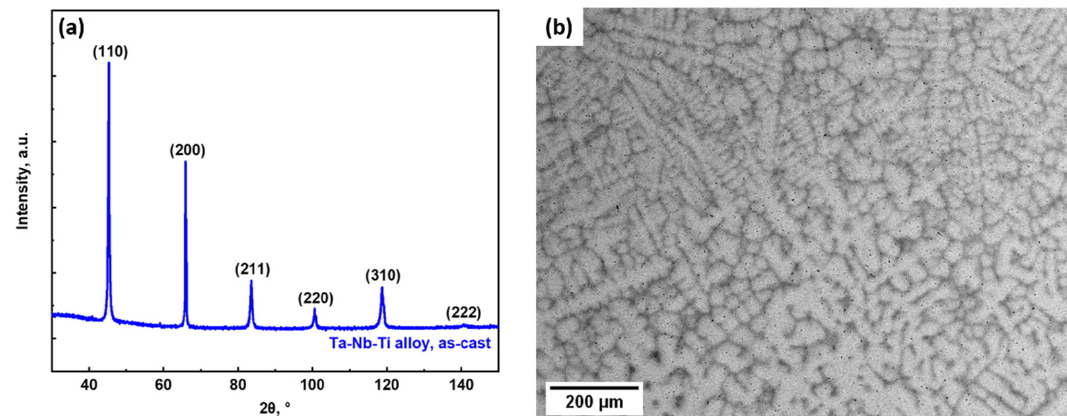
Figure 3. ( a ) XRD pattern of the Ta-Nb-Ti alloy in the as-cast condition. ( b ) SEM backscattered elec- tron (BSE) image of the alloy Ta-Nb-Ti.